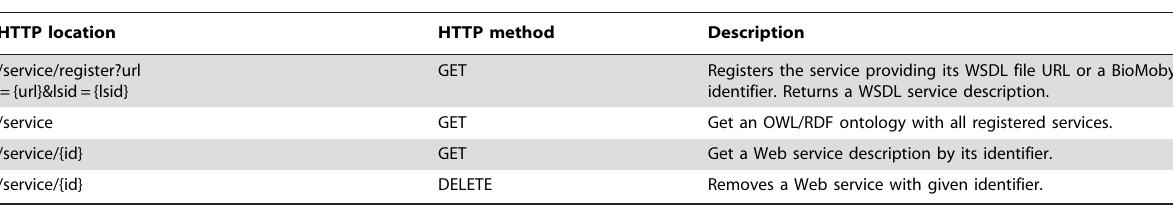
Table 1. BioSWR REST Web services API.